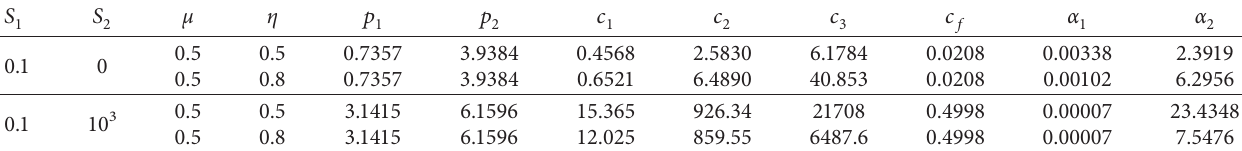
Table 1: Values of parameters involved in different cases ( K